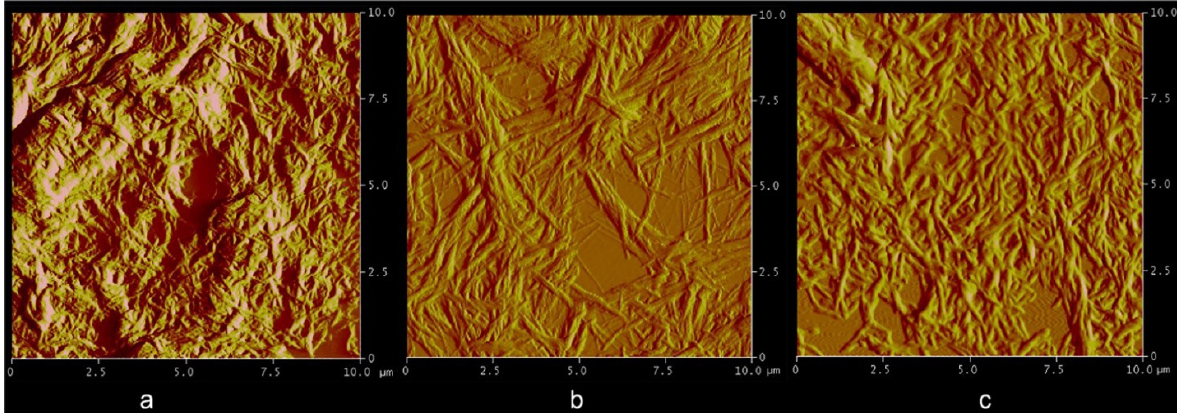
Figure 13. Atomic force microscopy (AFM) phase images of the gels formed by: ( a ) compound 20c in water at 2.9 mg/mL; ( b ) compound 20j in DMSO/H 2 O ( v / v 1:2) at 1.4 mg/mL; ( c ) compound 20l in DMSO/H 2 O ( v / v 1:8) at 2.25 mg/mL with toluidine blue dye (0.031 mg/mL) entrapped. Reprinted with permission from [52]. Copyright 2020 American Chemical Society.